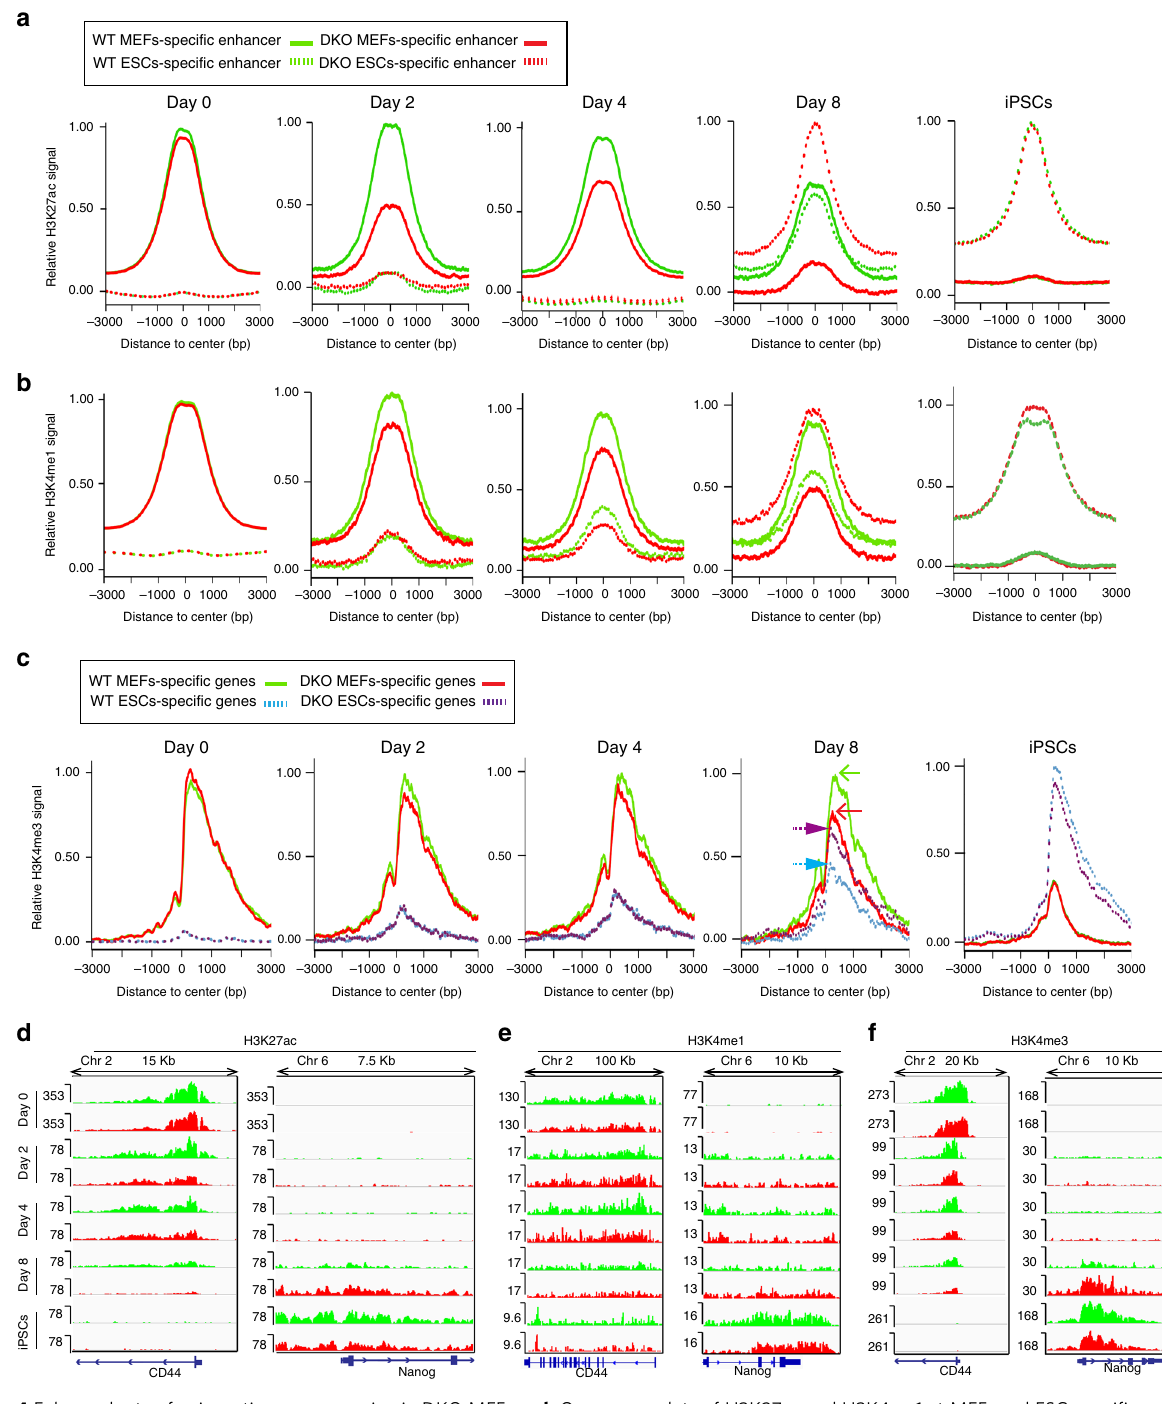
Fig. 4 Enhanced rate of epigenetic reprogramming in DKO MEFs. a , b Occupancy plots of H3K27ac and H3K4me1 at MEF- and ESC-speci fi c enhancers. c , H3K4me3 levels at promoters of genes speci fi cally expressed in either MEFs or ESCs. d – f IGV screenshots visualizing epigenetic changes during reprogramming at a MEF-speci fi c ( CD44 ) and ESC speci fi c ( Nanog ) expressed genes. For a - c the average of two biological replicates are level of H3K27ac and H3K4me1, two histone modi fi cations that